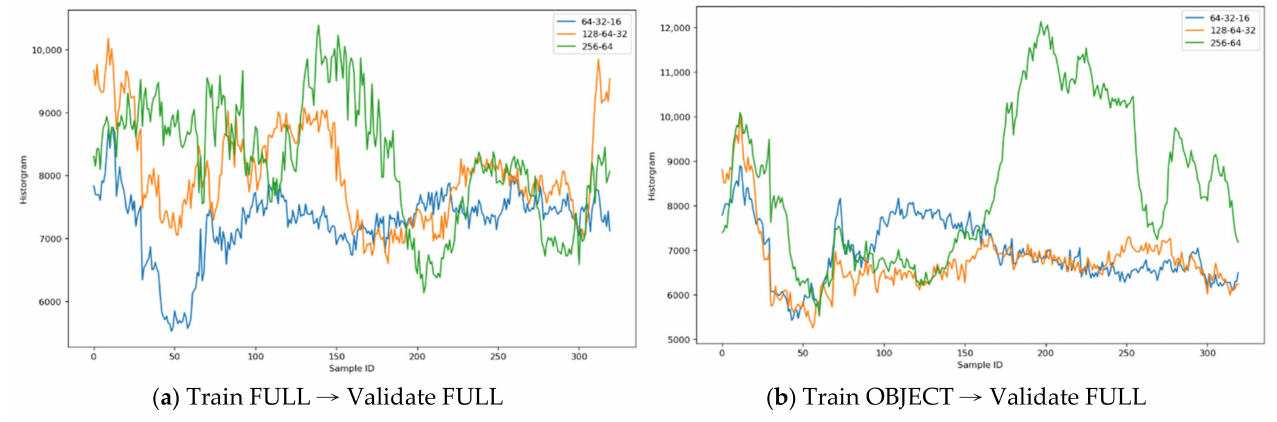
Figure 10. MLP model histograms